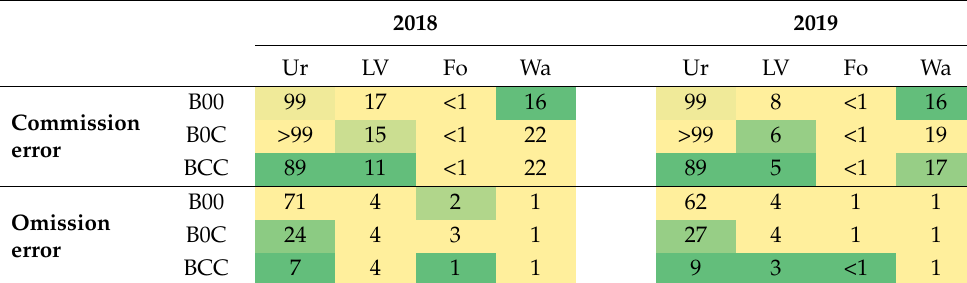
Figure 10. Tropical site percentage of forest pixels misclassified as low vegetation disaggregated by sub-swaths.